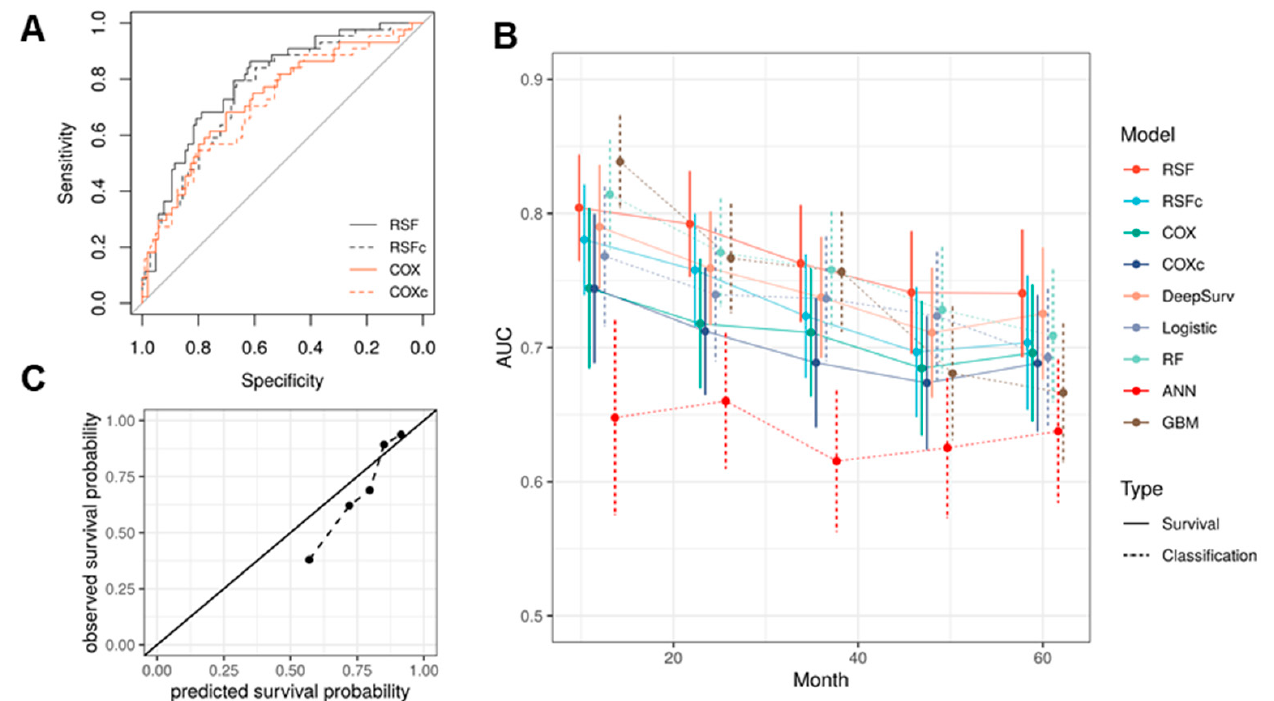
Figure 2. RSF predicts HNSCC patients’ overall survival. ( A ) The ROC curves of the predicted risk by the survival models against observed survival at year two. ( B ) RSF achieved highest AUCs in predicting OS at year 2~5 among the models tested. ( C ) Model calibration of RSF by comparing the predicted and observed two-year survival probability. The black solid line denotes the perfect calibration line. Table 4. Model test performance measured by C-index and AUC of two-year survival. The cutoffs were selected by maximizing the Youden index. For classification models, the C-index is obtained based on the predicted two-year survival probability.